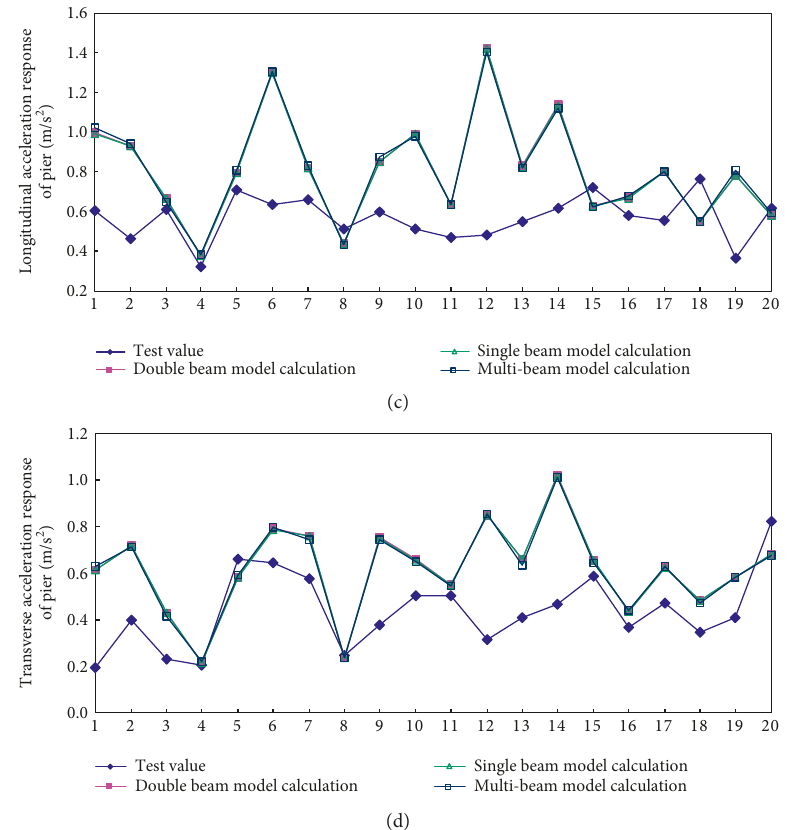
Figure 3: Acceleration response under longitudinal seismic waves. (a) Left end of bridge deck. (b) Right end of bridge deck. (c) Longitudinal acceleration response of pier. (d) Transverse acceleration response of